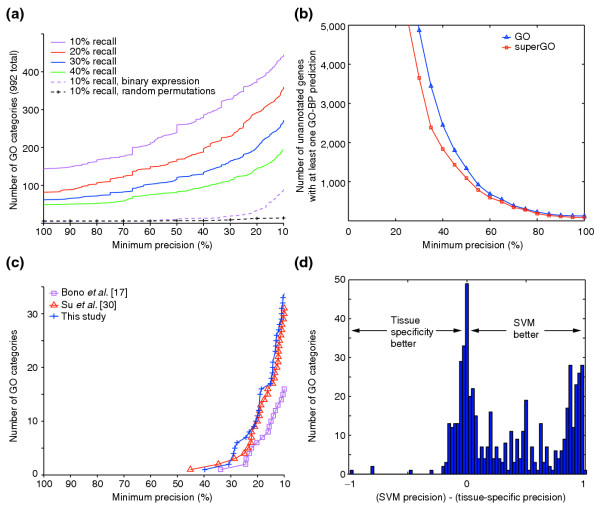
Predicting GO-BP categories of mouse genes using microarray data and SVMs. (a) The number of the 992 initial GO-BP categories exceeding the indicated precision value, with recall fixed for each line; for example at 40% recall (green line), around 100 categories achieve precision of 30%. To estimate the significance of the colored lines, we repeated their calculation after permuting the gene labels in the annotation database. The dotted gray line indicates the maximum number of GO categories that achieve the indicated precision, with recall of 10% or greater. The dotted magenta line indicates the result obtained using 'binary' expression data (expressed/not expressed) in each tissue. (b) The number of genes with predicted GO-BP categories (blue line) or superGO categories (red line) at varying precision values. The individual predictions are given in the Additional data files. (c) Comparison of the overall predictive capacity of three data sets, restricted to the 13 tissues and 1,800 genes shared by all three data sets. Each of the lines corresponds to the 30% recall line in (a). All of the lines are to the lower right of those in (a), since fewer genes and tissues were used. (d) A histogram comparing the precision of predictions derived from lists of tissue-specific genes with the precision of predictions from SVMs. For each category, the tissue-specific list yielding the highest precision value was identified, along with its associated recall value, and the SVM precision for the same category at the same recall value was identified. The difference between the two precision values is plotted for each category, such that instances where the SVM is superior are to the right of center.